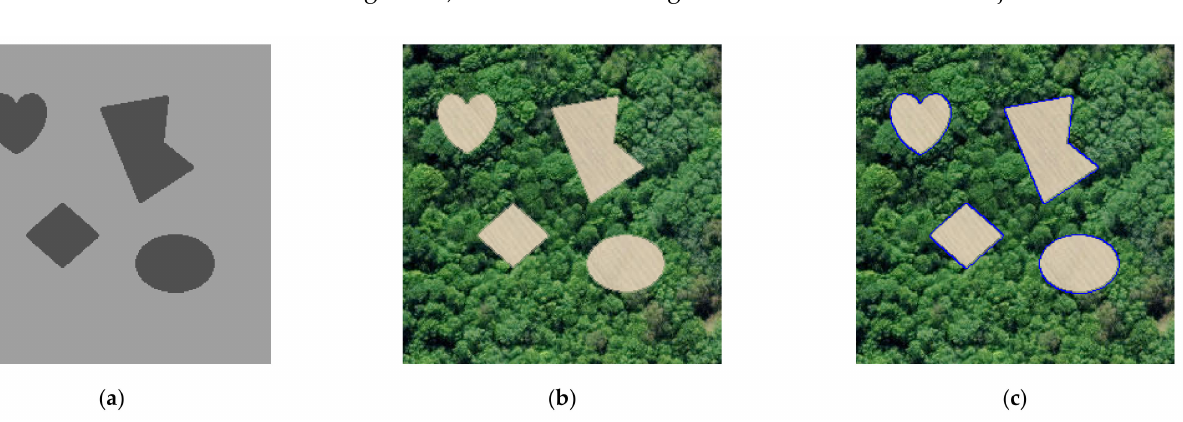
Figure 5. Synthetic images: ( a ) Template image; ( b ) Synthetic image; ( c ) Standard